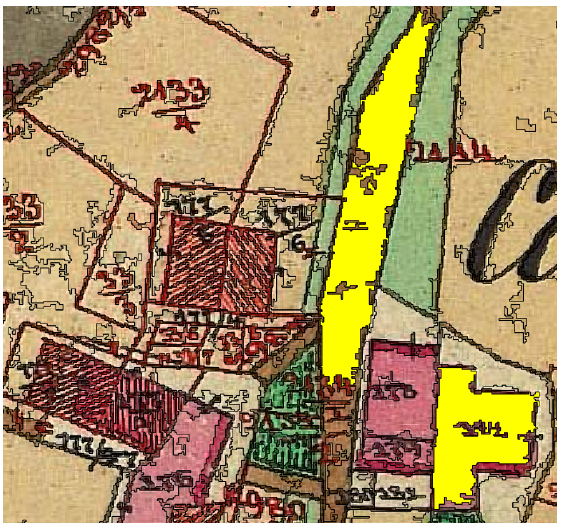
Figure 5. Details of the segments map for the cadaster map: the two segments in yellow, corresponding to a building and a road section, have similar area and perimeter but different shape; therefore, fractal dimension, square ratio and circle ratio facilitate their correct